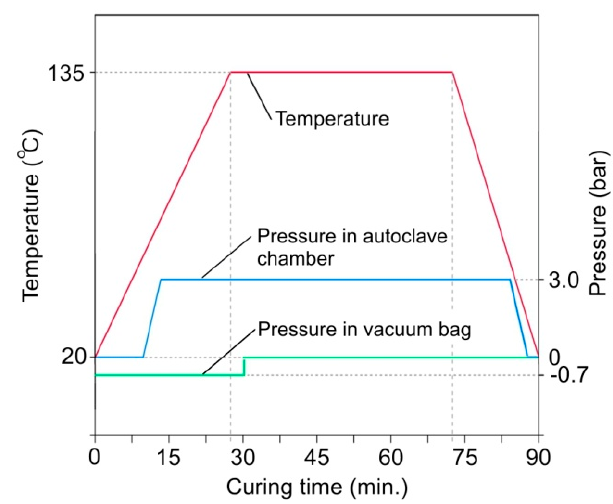
Figure 4. Autoclave cure cycle.